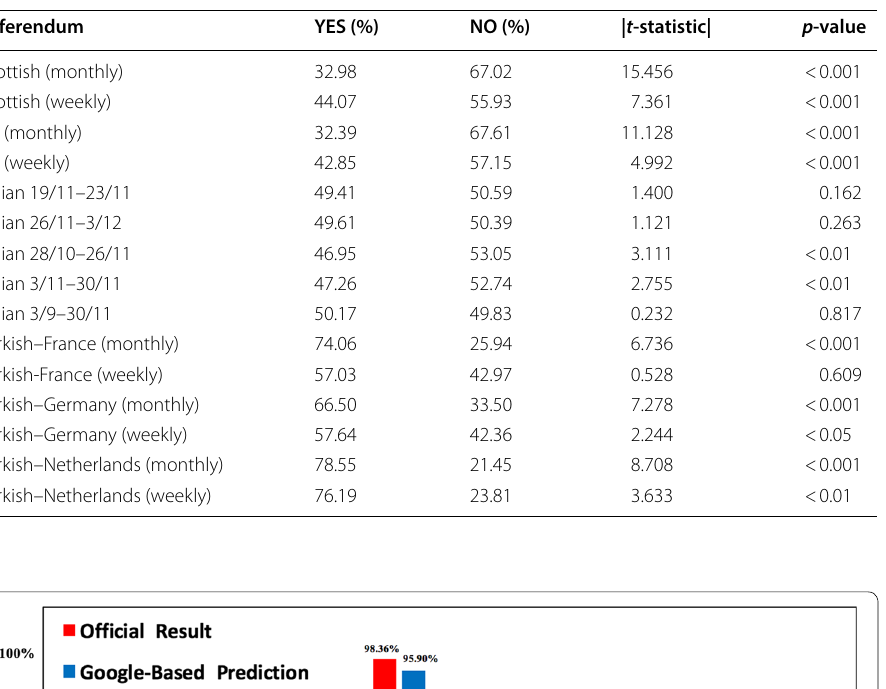
Table 1 Mean comparisons for the YES and NO percentized hits